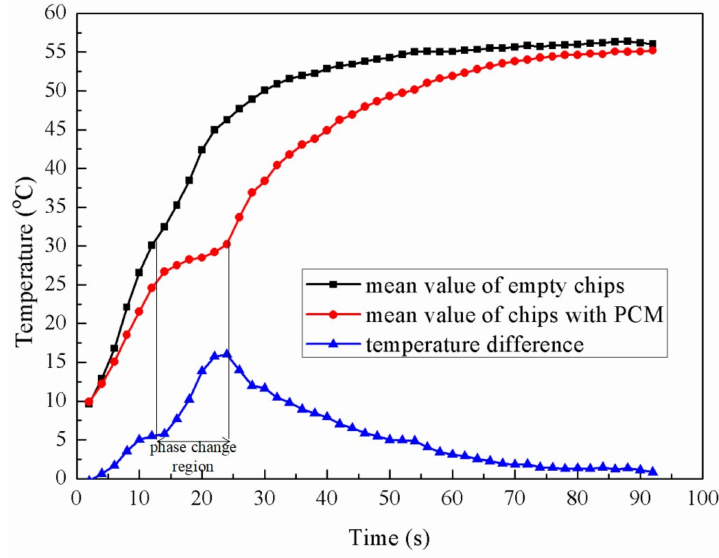
Figure 14. Mean value of the temperature of three empty chips, mean value of the temperature of three chips with PCM, and the temperature difference during the heating